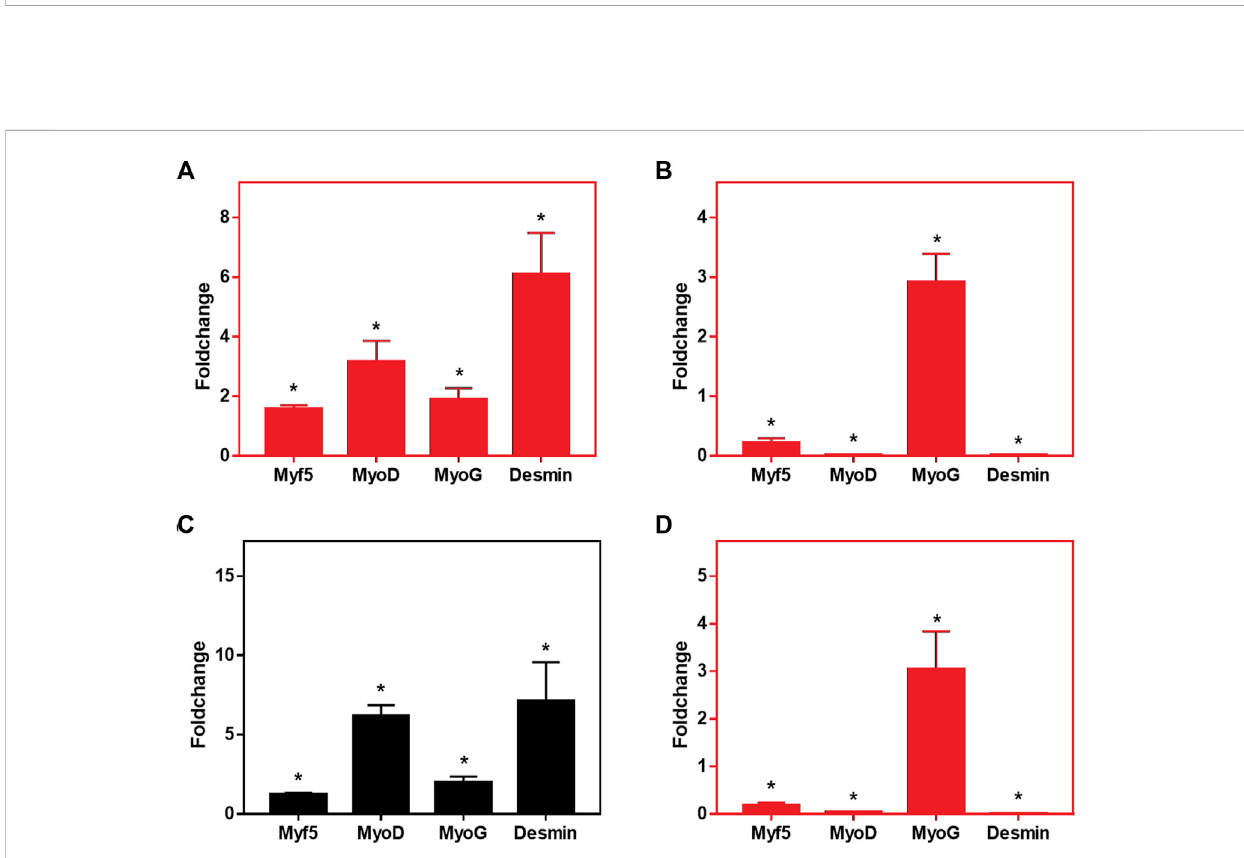
FIGURE 7 Relative expression levels of MyoD , Myf5, MyoG and Desmin in C2C12 cells cultured onto CA and CA@A nano fi bers. (A) Relative gene expression analysis after 7 days of culture, comparing CA x CA@A. (B) Relative gene expression analysis after 14 days of culture, comparing CA x CA@A (C) Relative gene expression analysis in cells cultivated onto the CA nano fi ber over time (7 days in GM x 7 days in GM followed by 7 days in DM). (D) Relative gene expression analysis in cells cultivated onto the CA@A nano fi ber over time. Signi fi cative data obtained by REST2009 software, using p <